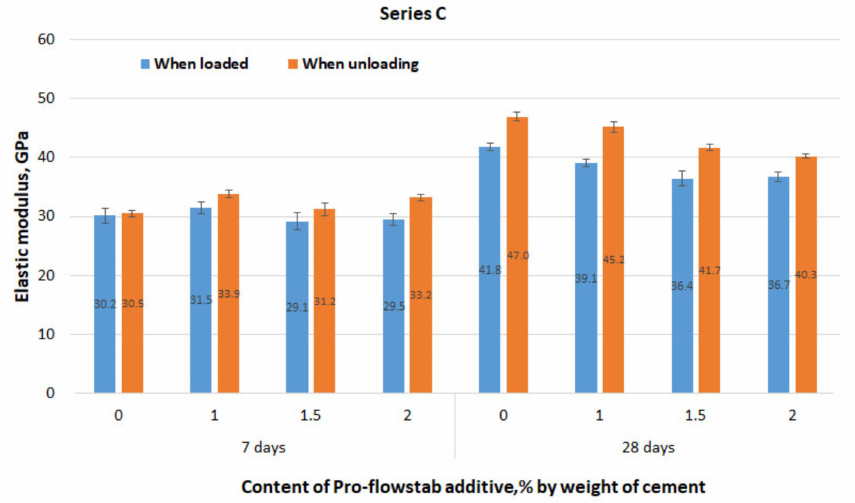
Figure 10. Values of tensile elastic modulus depending on the content of MFC